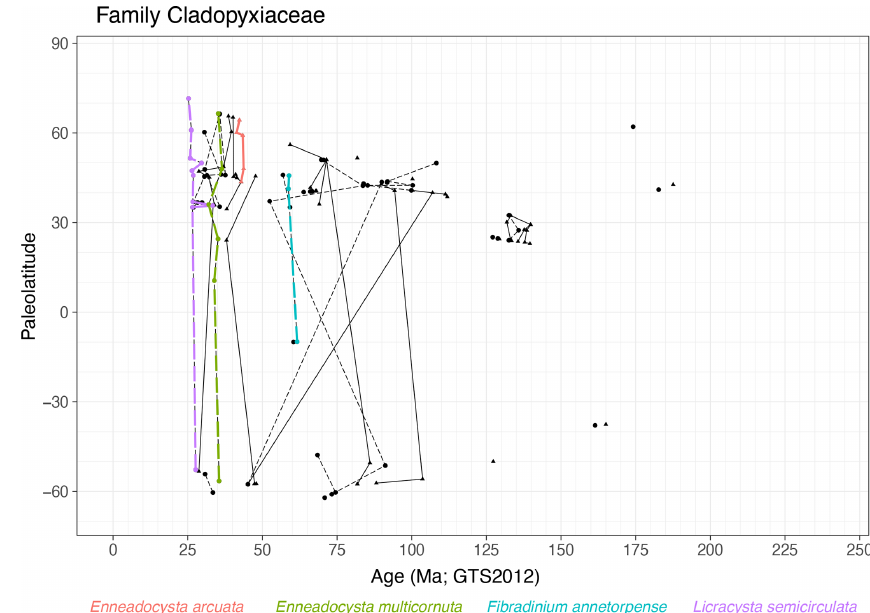
Figure 7. Same as Fig. 5 but for the family Cladopyxiaceae.